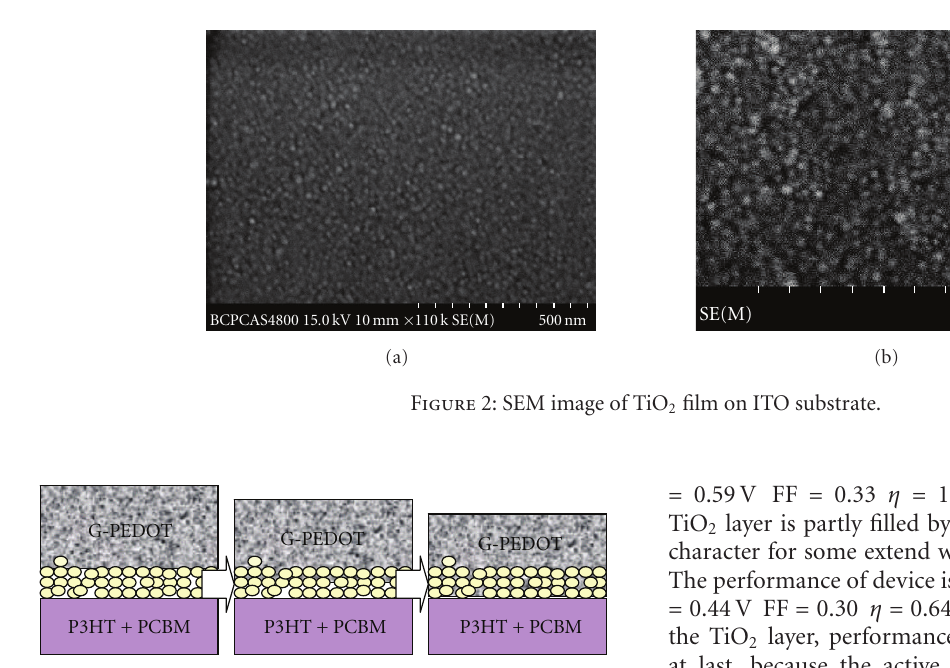
Figure 3: Illustration showing the forming process of TiO 2 /G- PEDOT nanocomplex